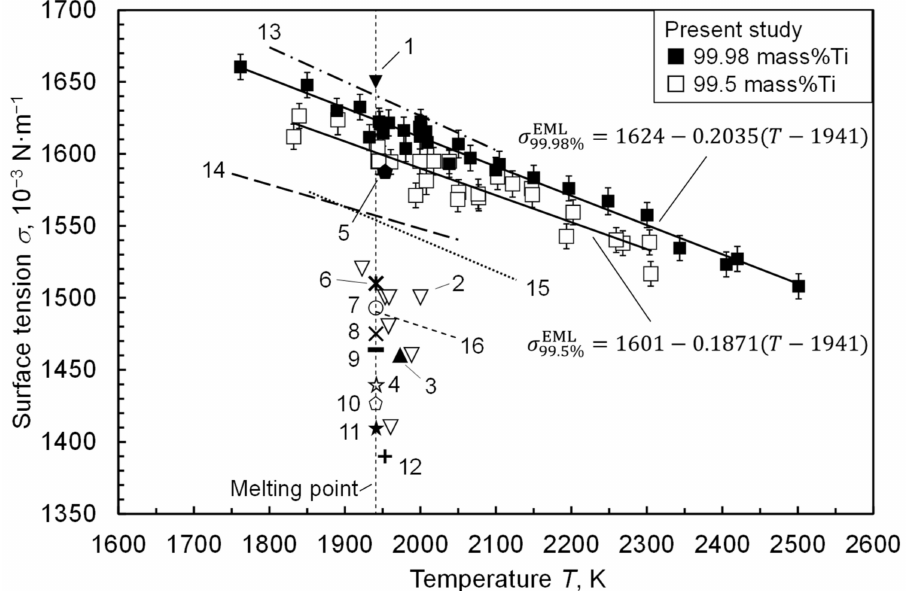
Figure 3. Temperature dependence of surface tension of liquid titanium with purity of ( (cid:4) ) 99.98 mass % and ( (cid:3) ) 99.5 mass % measured at P O of 10 − 2 Pa under Ar–He 2